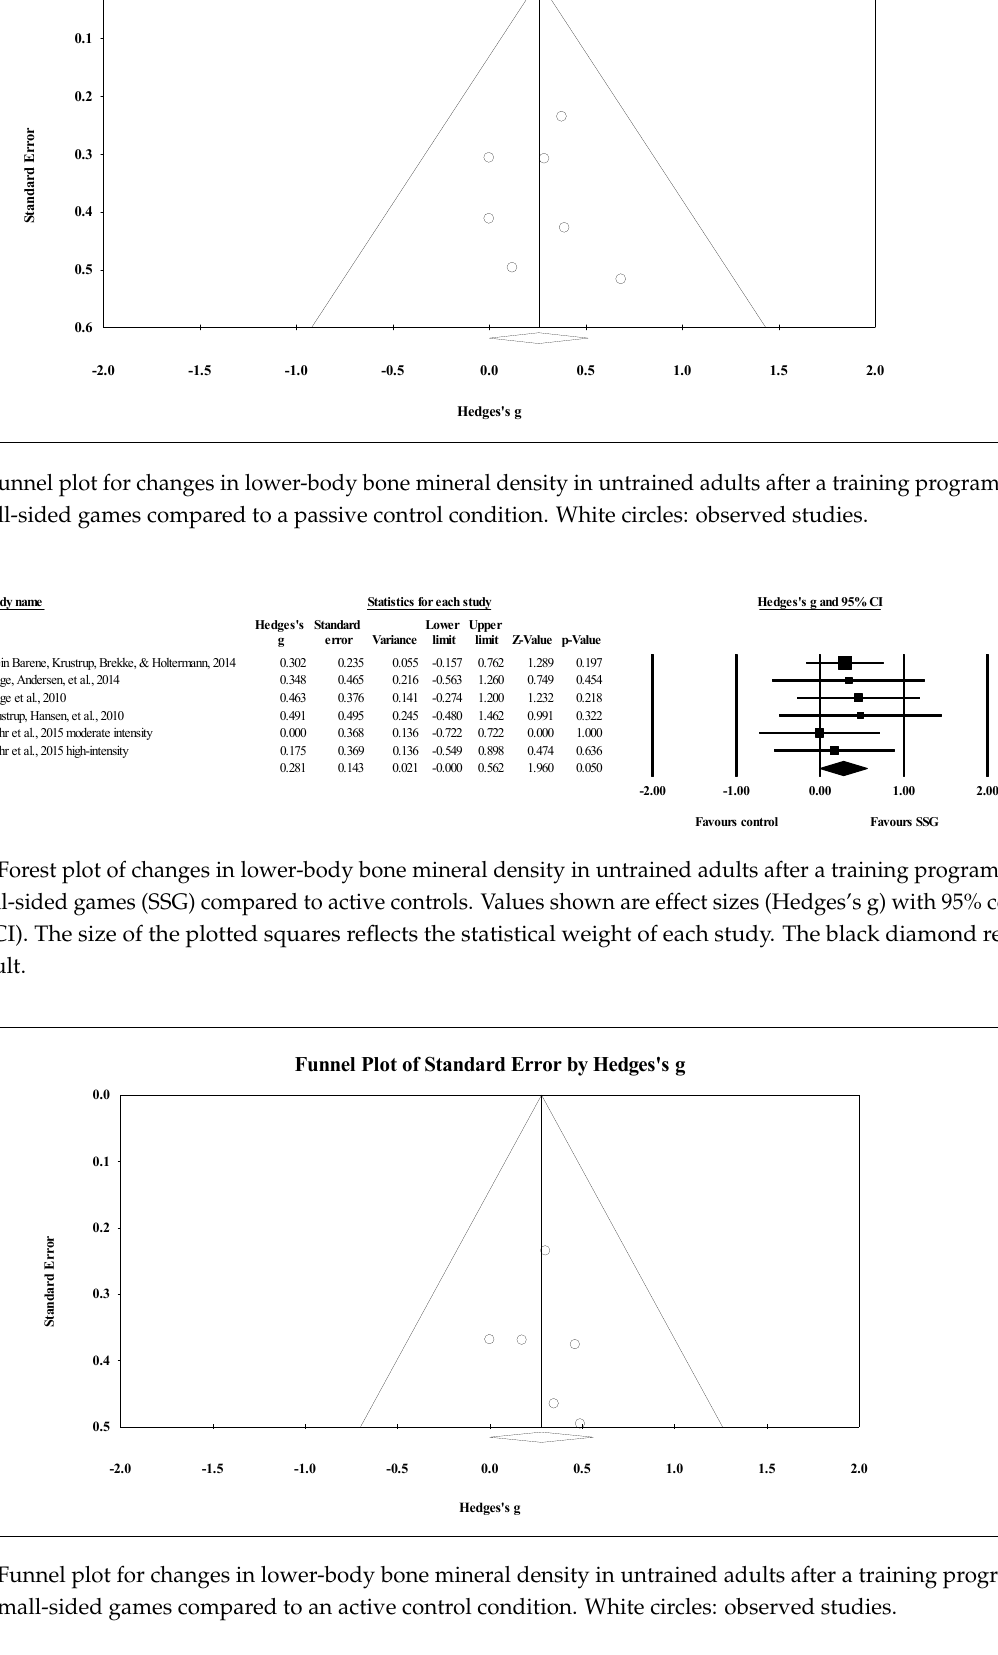
Figure 8. Forest plot of changes in lower-body bone mineral density in untrained adults after a training program based on soccer small-sided games (SSG) compared to controls. Values shown are effect sizes (Hedges’s g) with 95% confidence intervals (CI). The size of the plotted squares reflects the statistical weight of each study. The black diamond reflects the overall result.